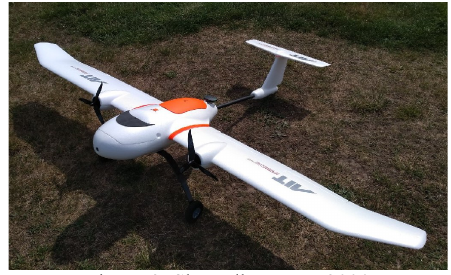
Figure 2. Skywalker